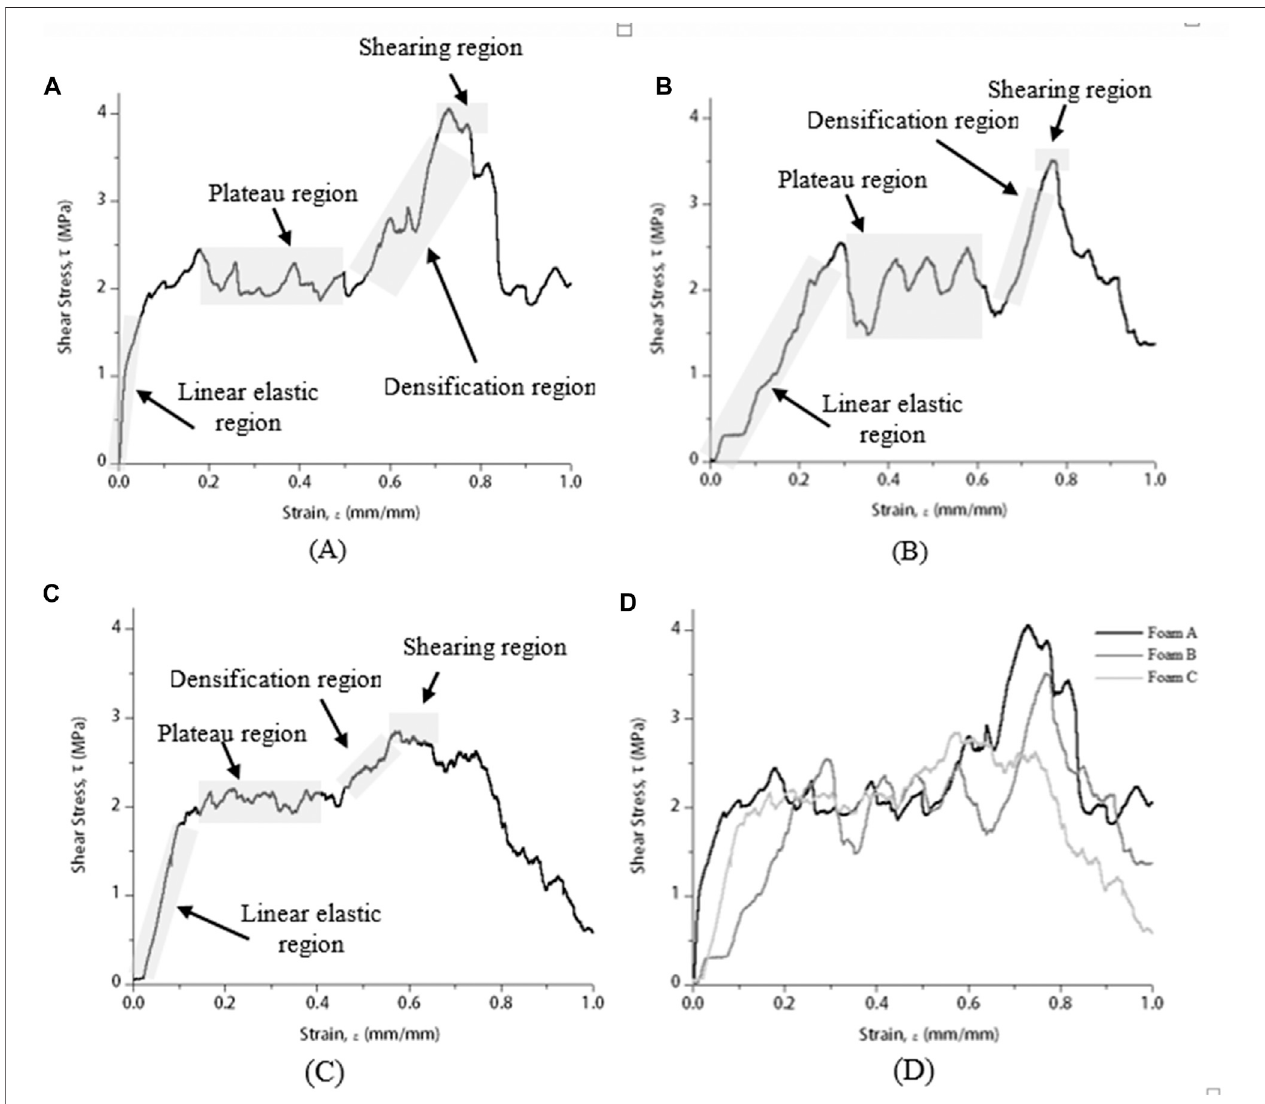
FIGURE5| Shearstress – straincurveofbrazedCu/Cufoam/Cuusingamorphous fi llerat680 ° CwithdifferentCufoamporedensitiesof (A) foamA, (B) foamB, (C) foam C, and (D) combined.